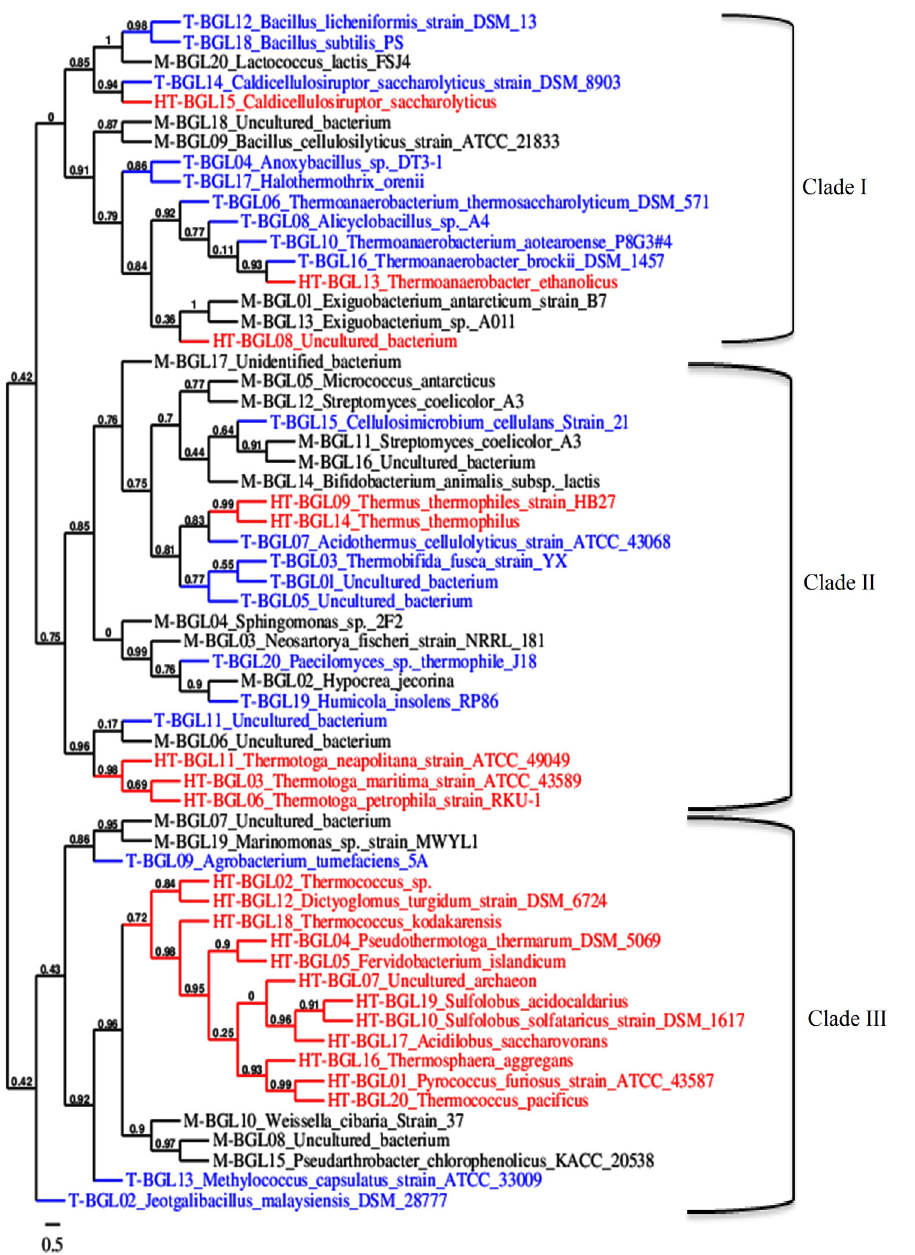
Fig. 1. Phylogenetic tree of mesophilic (Black, M-BGL), thermophilic (blue, T-BGL) and hyperthermophilic (red, HT- BGL) β -glucosidases from bacteria, archaea, and fungi. This phylogenetic tree was constructed using Phylogeny